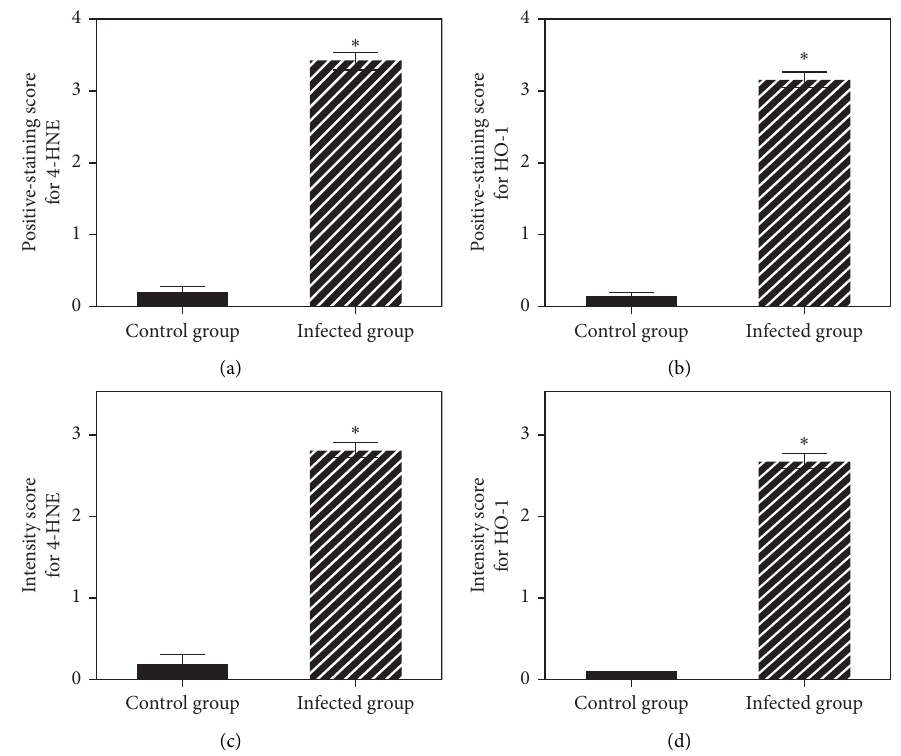
Figure 4: Semiquantitative analysis of 4-HNE and HO-1 expression in kidney sections from the control (a) and P. berghei -infected groups (b). ∗ Significant ( p < 0 . 05) difference compared with the control group.